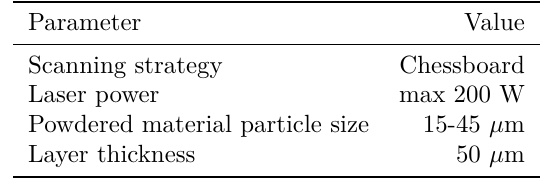
Table 1. Parameters of SLS procedure